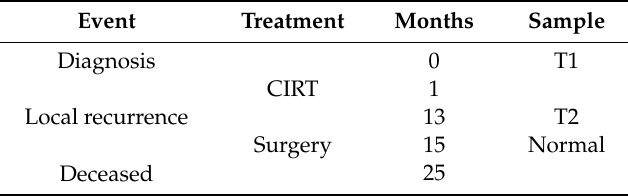
Table 1. Clinical course of the patient and timing of sample